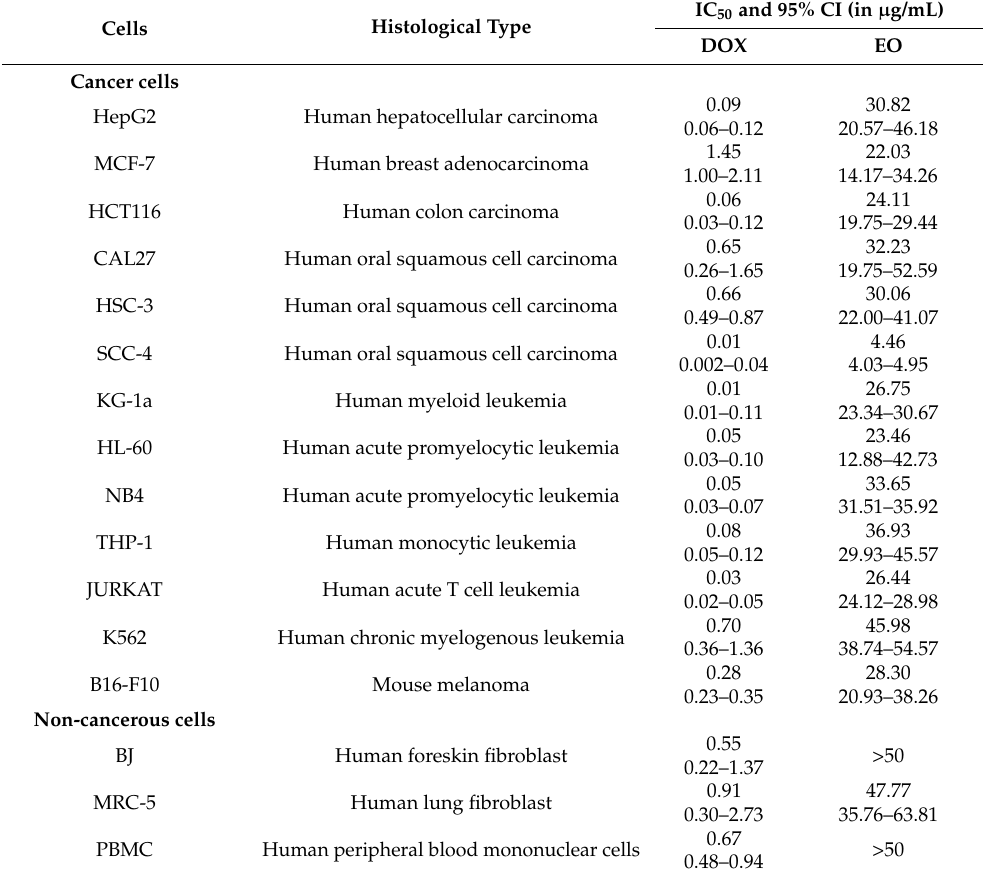
Table 2. Cytotoxic activity of G. olivacea leaf